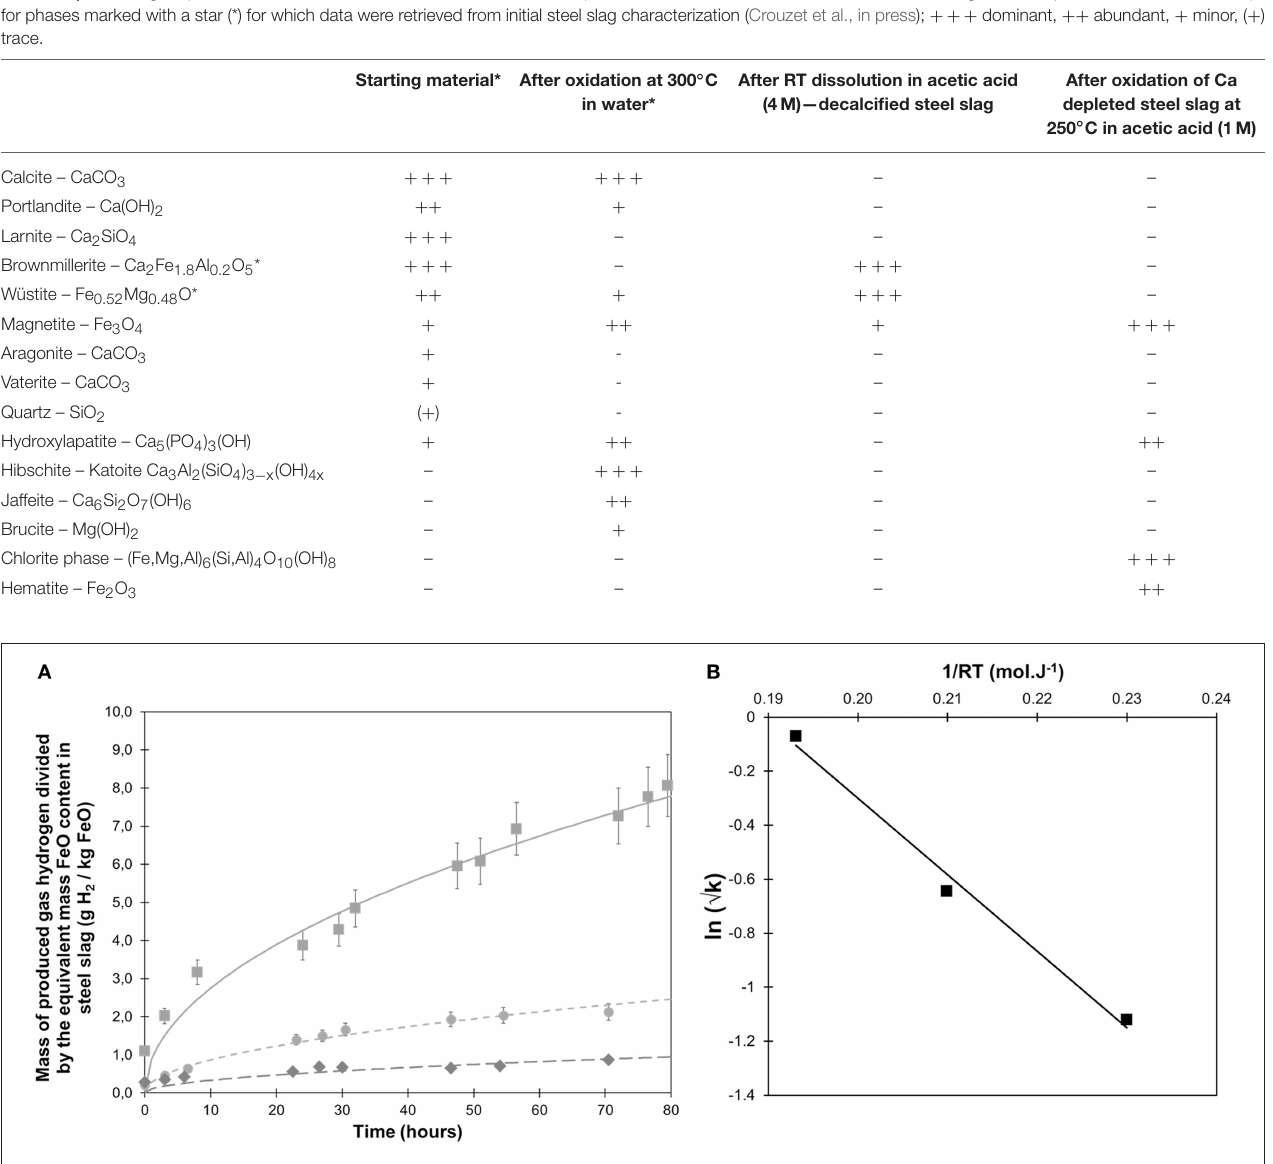
FIGURE 1 | (A) Hydrogen production monitored as a function of time at 250 ◦ C (diamonds, APW-250C ), 300 ◦ C (circles, APW-300C ) and 350 ◦ C (squares, APW-350C ) from steel slag hydrothermal oxidation in de-ionized water; pressure reached 160 to 190 bar after heating; (B) Arrhenius plot of the retrieved kinetic constants using a square-root rate